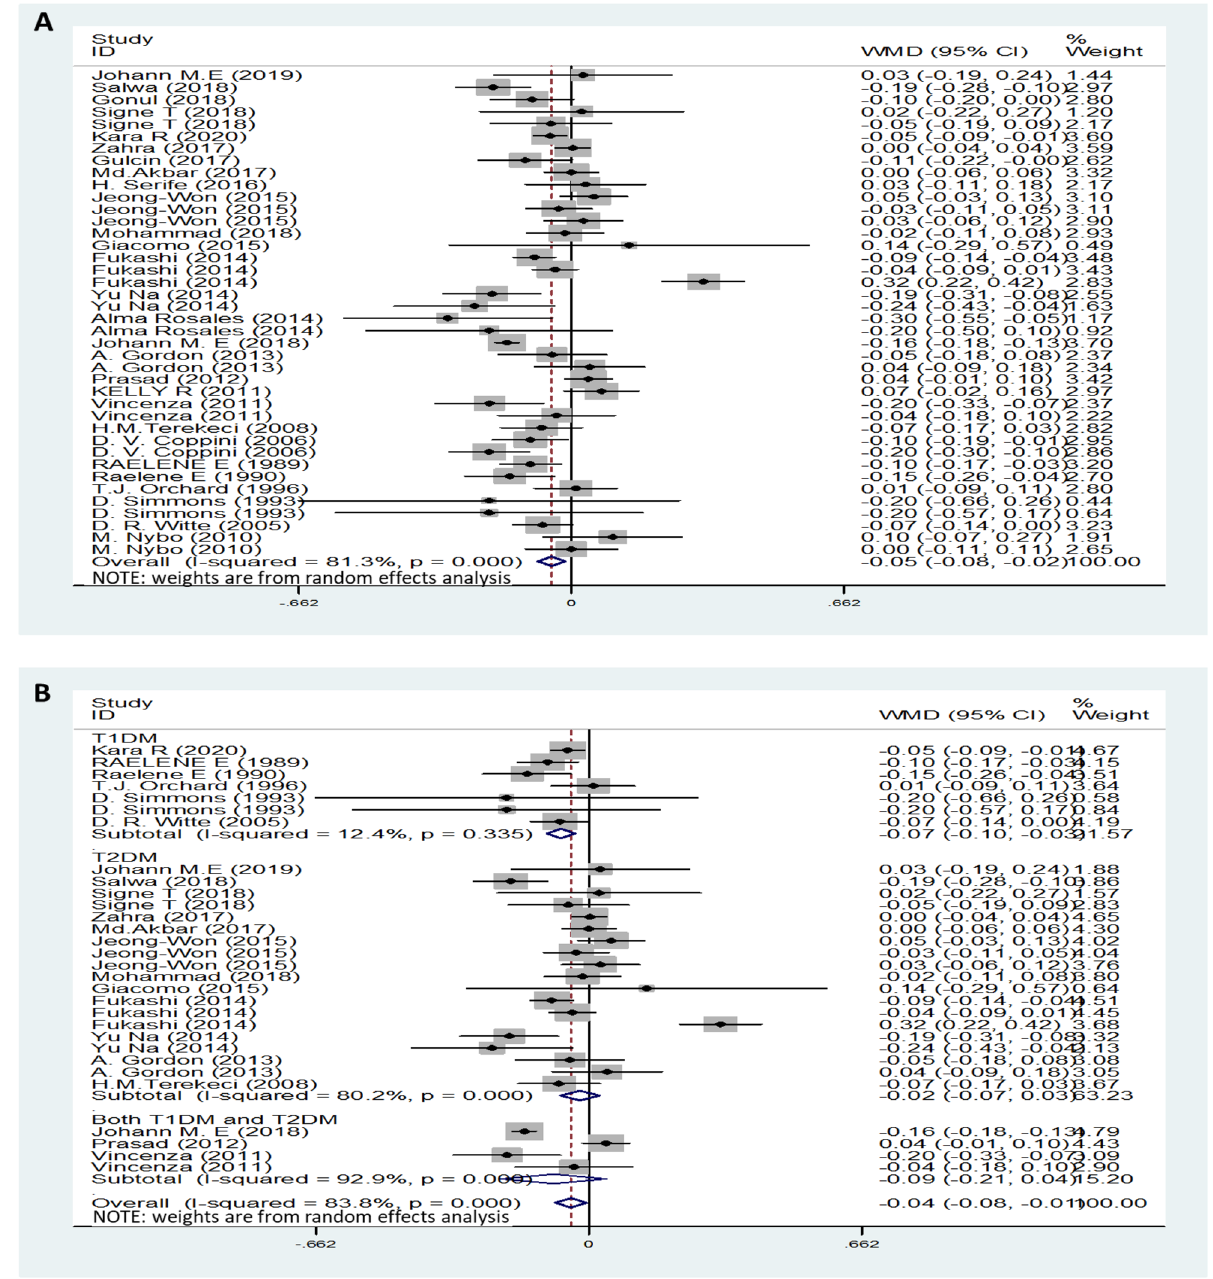
Figure 4. HDL levels ( A ) in people with DN versus those without DN. HDL levels in the subgroup analysis stratified by the type of diabetes ( B ) and symptom severity ( C ). OR ( D ) for DN in patients according to serum HDL